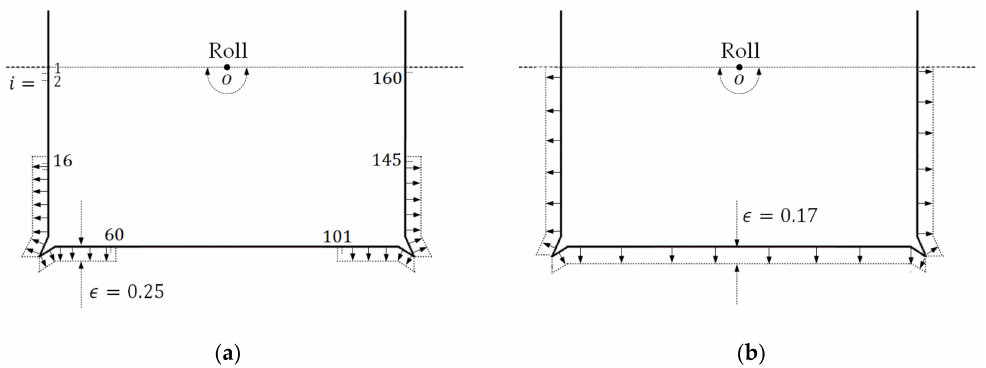
Figure 3. Two viscosity distribution approaches for TGF_N_V. (a) (cid:101) = 0.25 for segments 16 ≤ i ≤ 60 and 101 ≤ i ≤ 145, while (cid:101) = 0 for the rest segments; (b) (cid:101) = 0.17 for all segments.